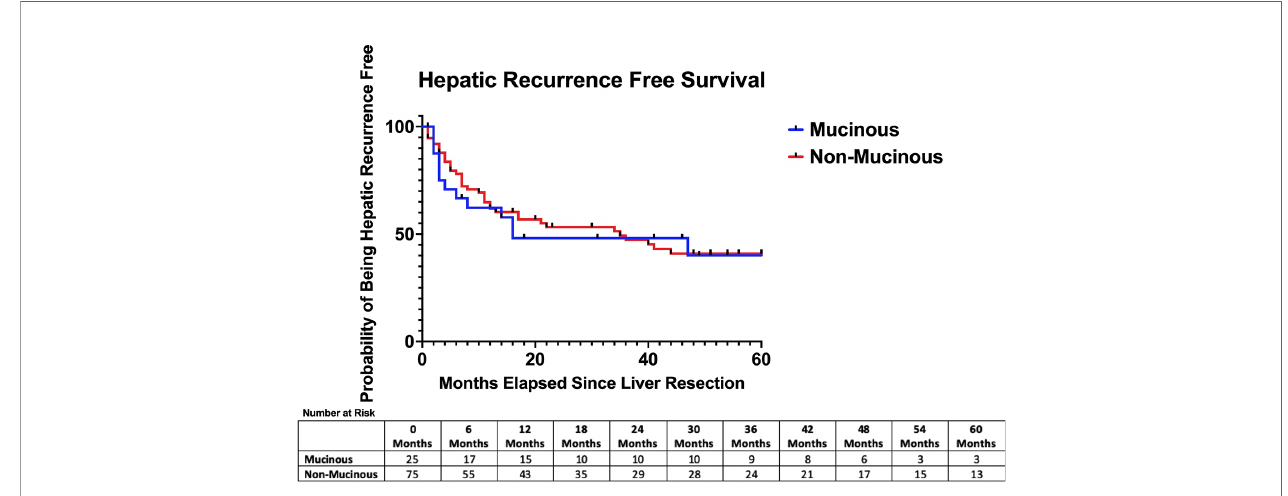
FIGURE 1 | Hepatic recurrence-free survival after hepatic resection. Median hepatic recurrence free survival = 16 months (mucinous) versus 35 months (non- mucinous) p =